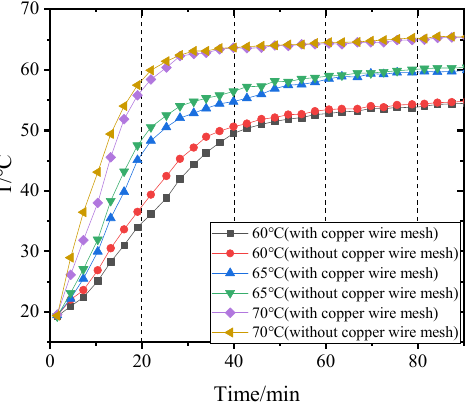
Figure 13. Variation of air temperature at the dehumidifier outlet with time when using PCM-2.